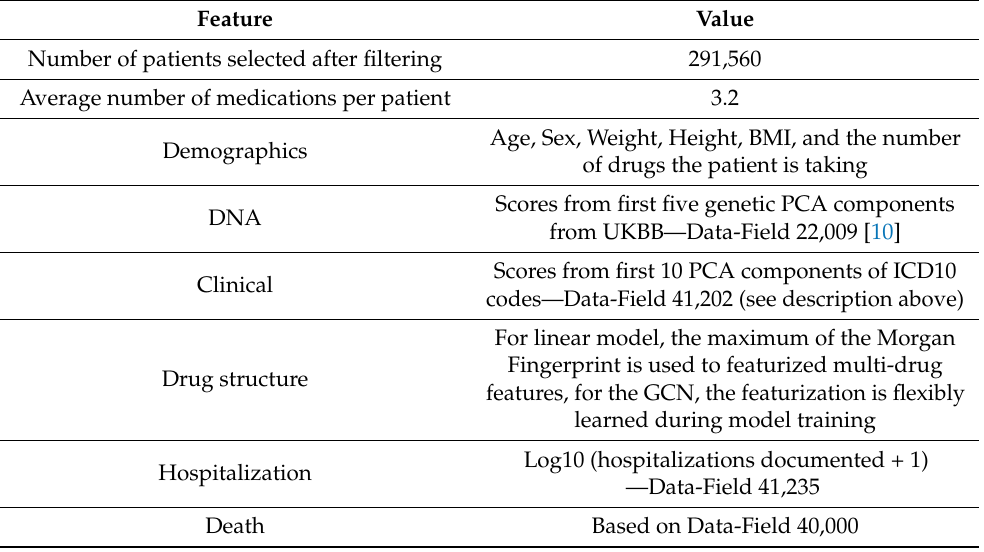
Table 1. Summary of key parameters of UKBB